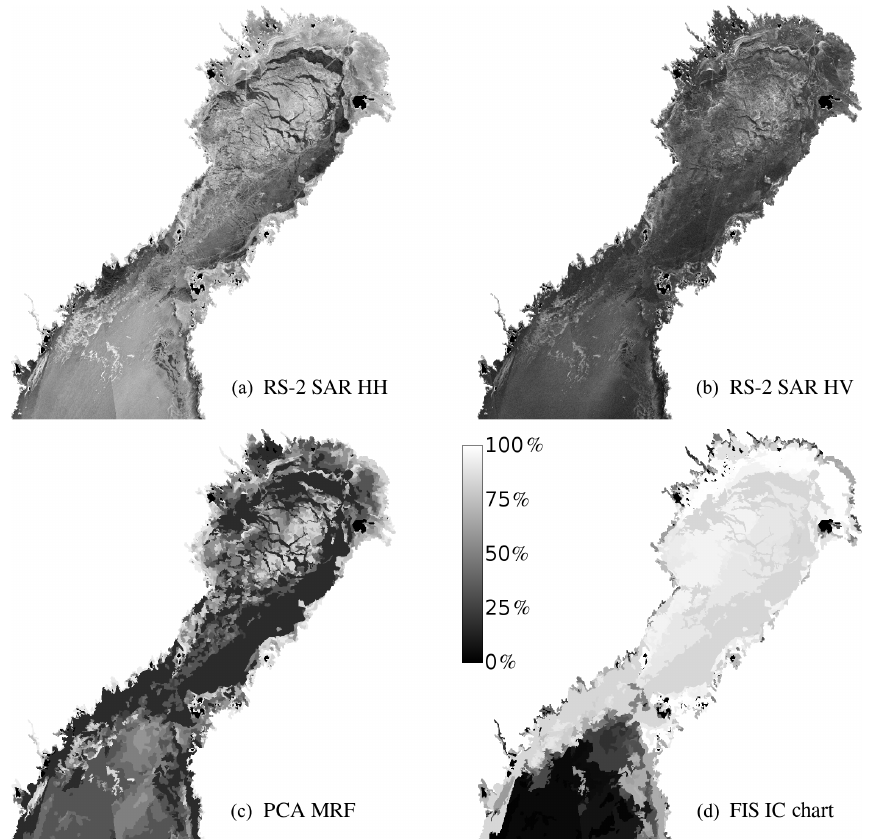
Figure 4. Example of RS2 SAR data from 9 February 2013 in HH (a) and HV (b) polarizations together with the segmentation result (c) and the SIC chart (d)